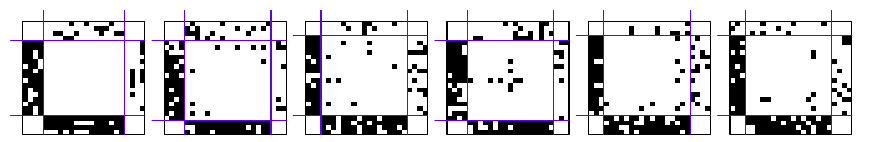
Fig 5. Some generated networks with the expected hierarchical blockmodel without complete blocks on the diagonal. The RL algorithm is used and all triad types are